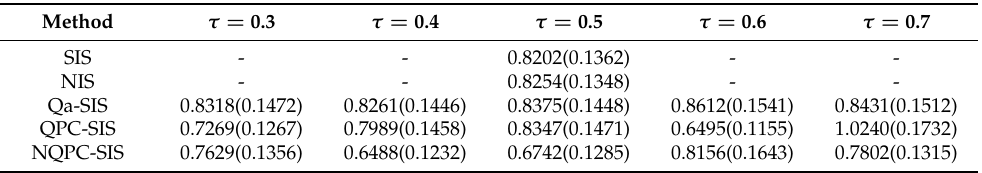
Table 7. Prediction results for the real data on the test set, where the standard deviation is given in the